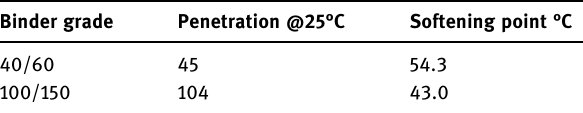
Table 1: Raw properties of bitumen